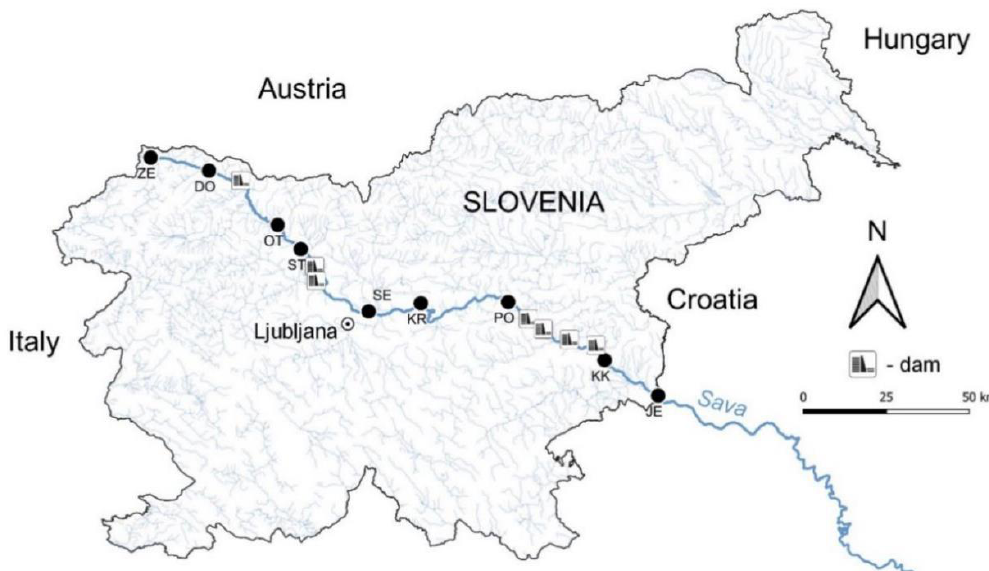
Figure 1. Map of locations of all sampling sites within the territory of Slovenia. The positions of dams and accumulations on the river Sava are also presented. The sampling sites: ZE - Zelenci, DO—Dovje, OT—Otoče, ST—Struževo, SE—Šentjakob, KR—Kresnice, PO—Podkraj, KK—Krško, JE—Jesenice na Dolenjskem.